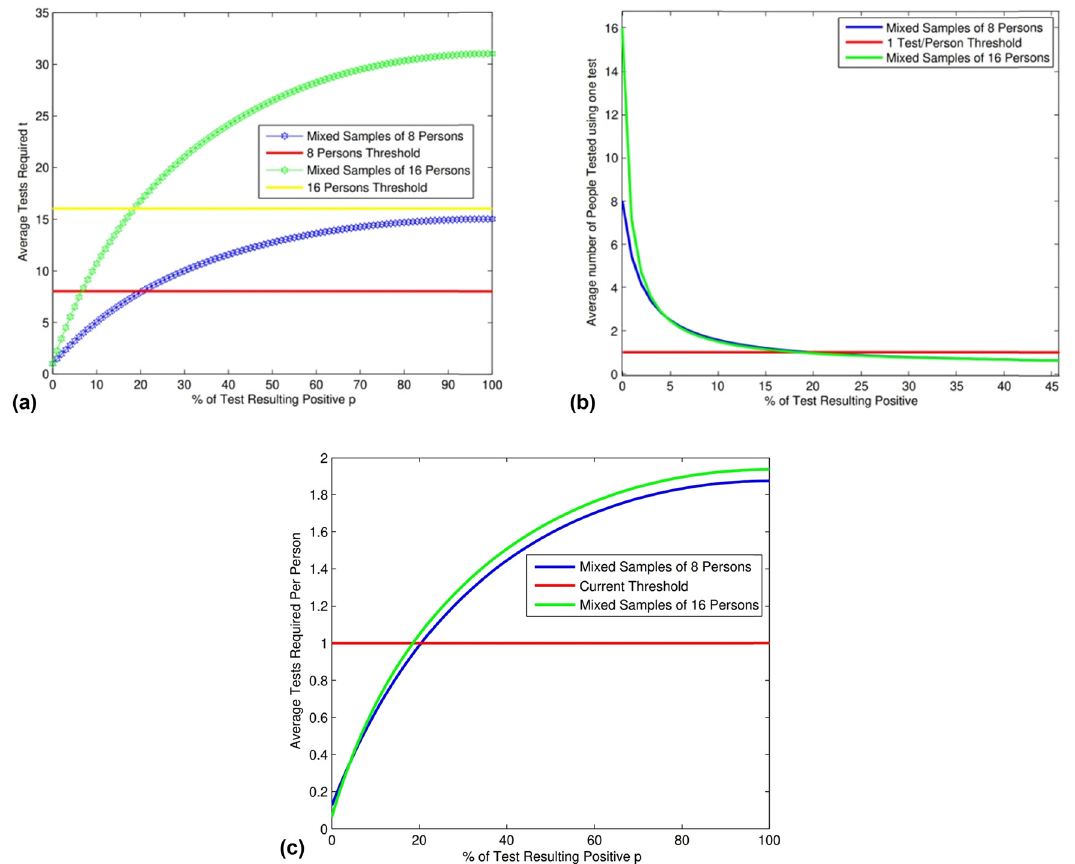
Figure 10: ( a ) Average tests are required for linear and pooled testing. ( b ) An average number of people tested with one test. ( c ) The average number of tests required per person for linear and pooled